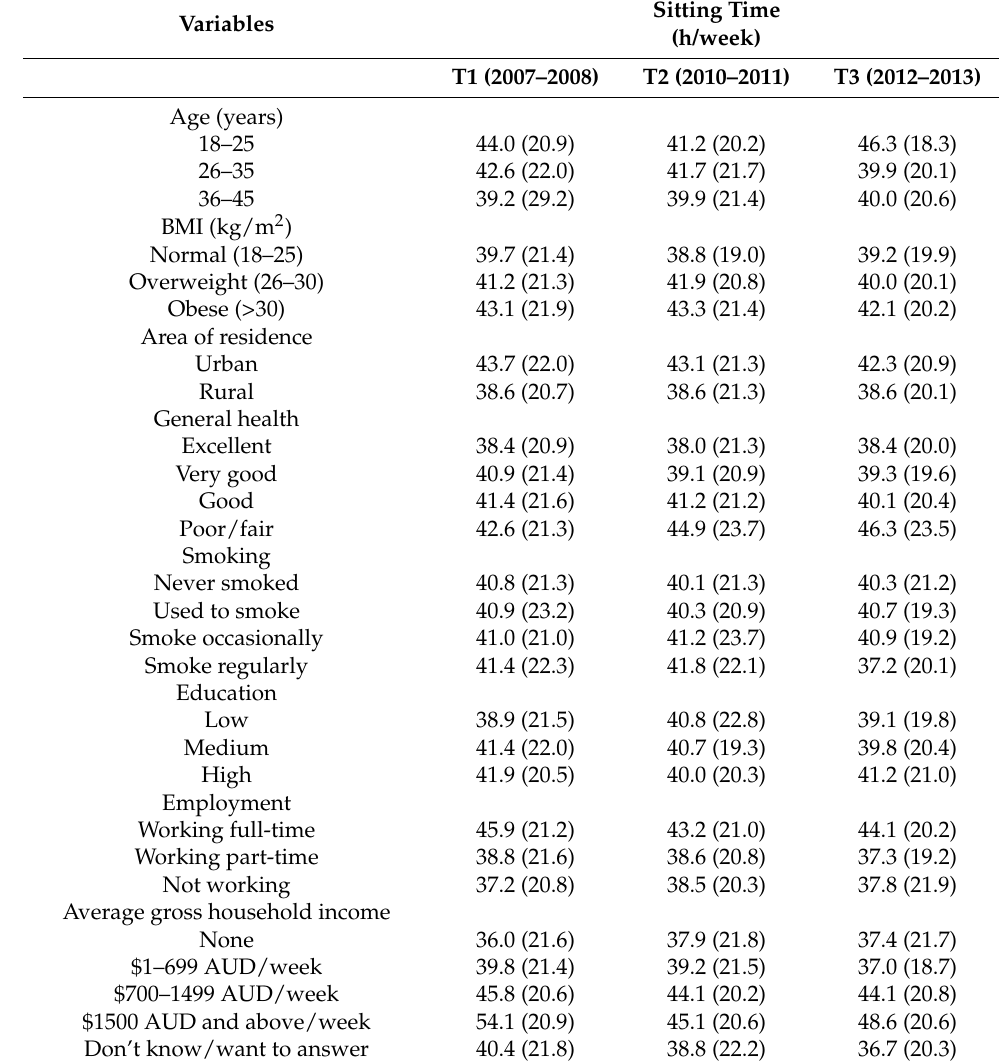
Table 2. Mean (SD) sitting time (h/week) and sociodemographic and health characteristics in the READI